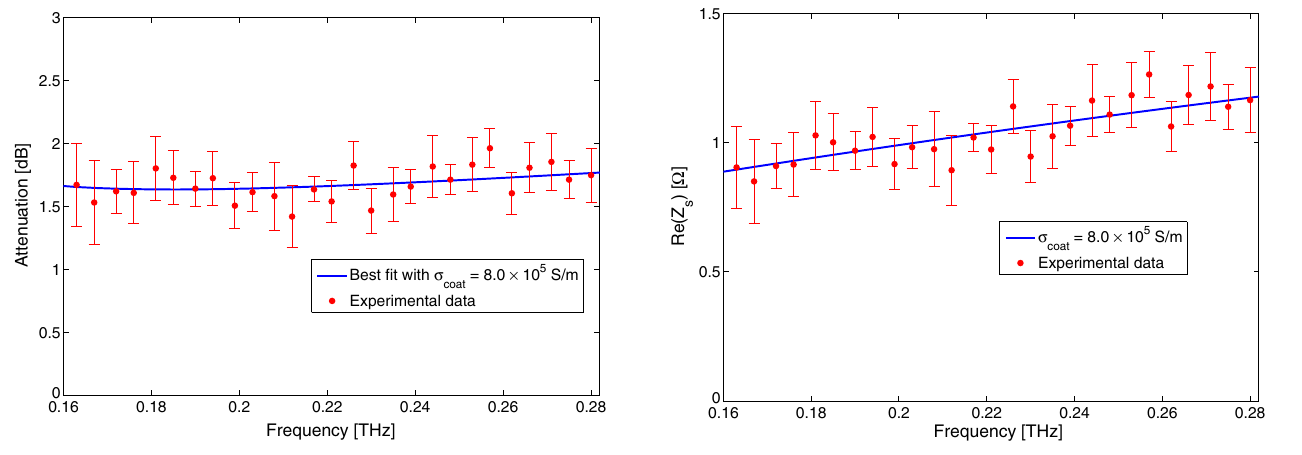
FIG. 16. Surface impedance estimation of the 3 . 96 μ m NEG coated slab: from averaged experimental data (red dots) and from best fit curve conductivity